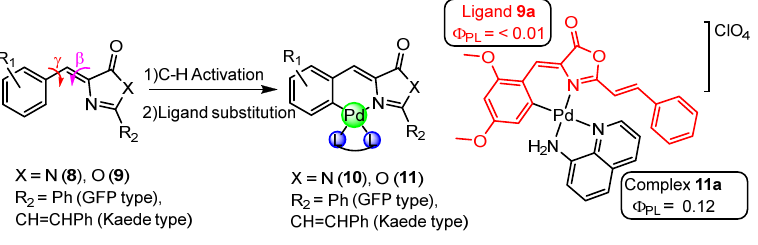
Figure 5. Amplification of the fluorescence of GFP-like fluorophores using Pd as an intramolecular lock. Adapted from